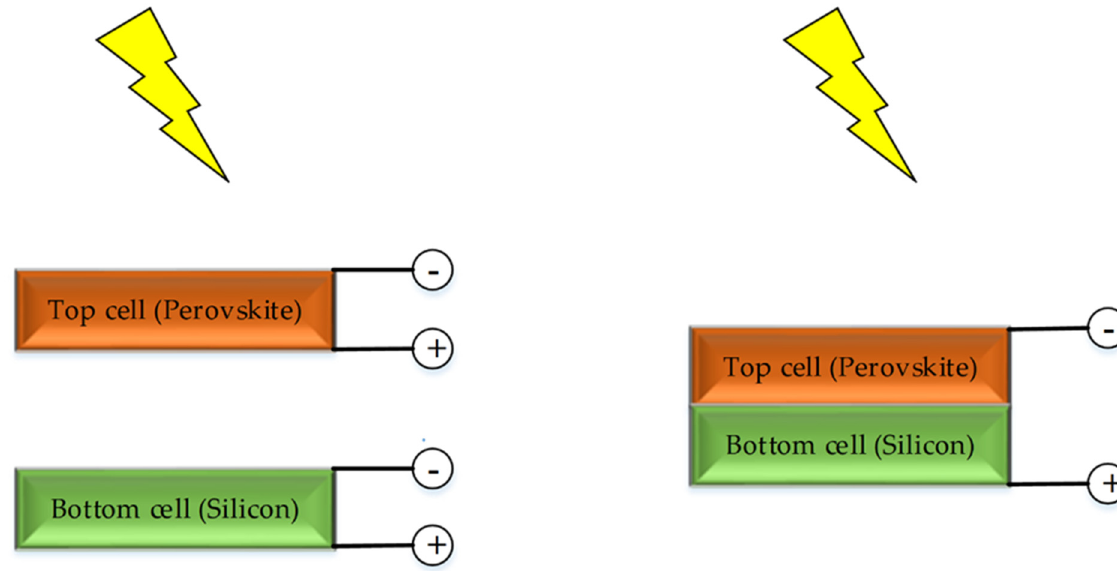
Figure 1. PSC-Si 4T ( left ) and 2T ( right ) simple schematic diagram.